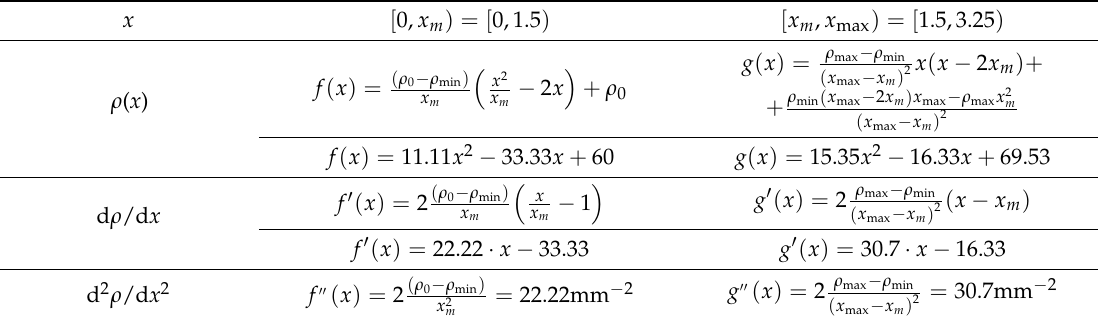
Figure 6. ( a1–a3 ), reflectivity profiles obtained using MATLAB from the en-face OCT images in Figure 4—for pressed ceramic. Row ( 2 ): reflectivity graphs, obtained as averages of these reflectivity graphs. Row ( 3 ): gradient of the reflectivity, obtained from Appendix A1, A2, and A3, as well as shown in Tables 1–3, respectively. Column ( a ), Group L: sample pressed at 840 °C (50 °C below the normal temperature). ( b1–b3 ), Group N: sample pressed at the normal temperature of 890 °C, prescribed by the manufacturer. ( c1–c3 ), Group H, sample pressed at 940 °C (50 °C above the normal temperature). Table 1. Modeling of the reflection functions: Group L—dental pressed